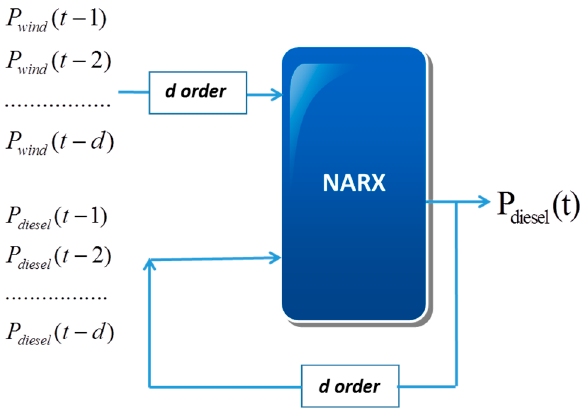
Figure 3. Non-linear auto-regressive model with exogenous inputs—back-propagation neural Figure 3. Non ‐ linear auto ‐ regressive model with exogenous inputs—back ‐ propagation neural network network (NARX ‐ BPNN).